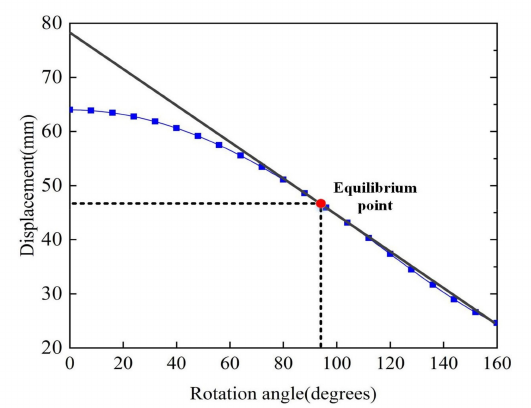
Figure 4. Nonlinear relationship between rotation angle θ and displacement s, and linear relationship at the equilibrium